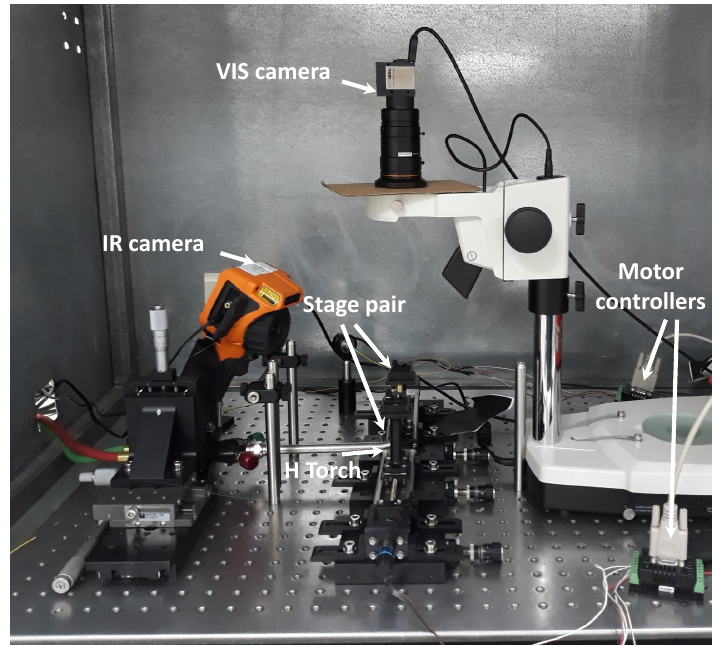
Figure 2. Pulling station including a pair of long-travel motorized stages with clamped posts, hydrogen torch producing a hot flame below the taper, and a pair of visible (above) and IR (side) control cameras used during microtaper preparation starting from a standard single-mode fiber.